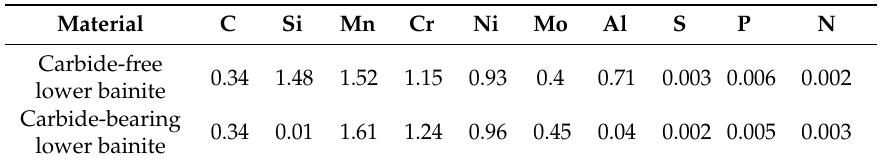
Table 3. Main mechanical properties.